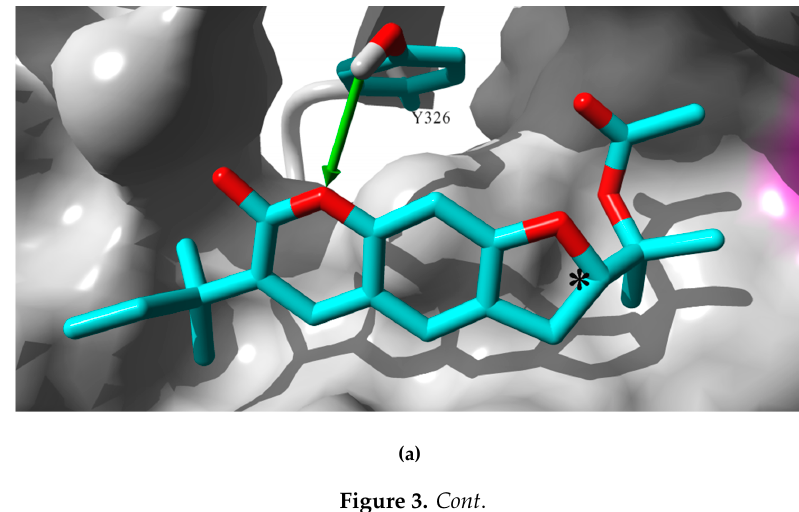
Figure 2. Monomer of h MAO ‐ B molecule with lowest energy pose of ( S ) ‐ rutamarin molecule docked into the binding cavity. Ribbon diagram of overall protein structure in gray, the loop formed by residues 99–109, which admits ligands into the active site is highlighted in yellow. The FAD cofactor molecule is colored in magenta and while the ( R ) ‐ rutamarin is presented in ball mode with atom color coding mode: carbon—cyan, oxygen—red and